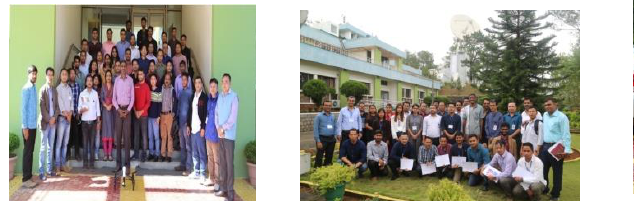
Figure 6: Participants during user specific UAV training at